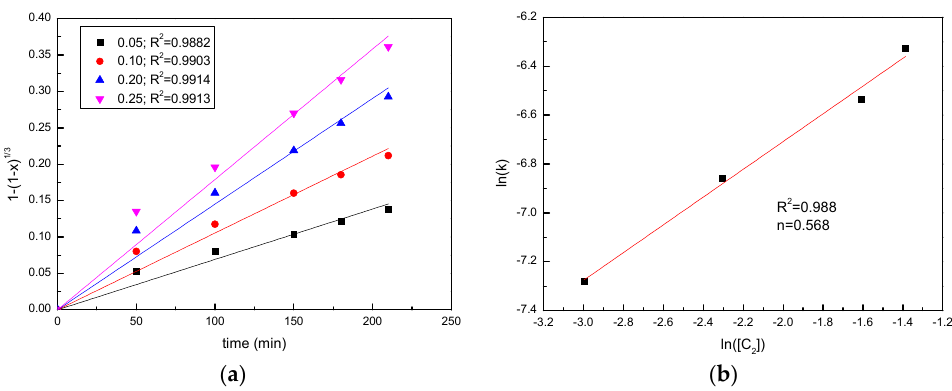
Figure 8. Analysis of reaction order with respect to sawdust/ore mass ratio ( a ) Plots of 1 − (1 − x ) 1/3 vs. time for manganese at various sawdust/ore mass ratios; ( b ) the determination of the reaction order with respect to the sawdust/ore mass ratio. Minerals 2016 , 6 , 83